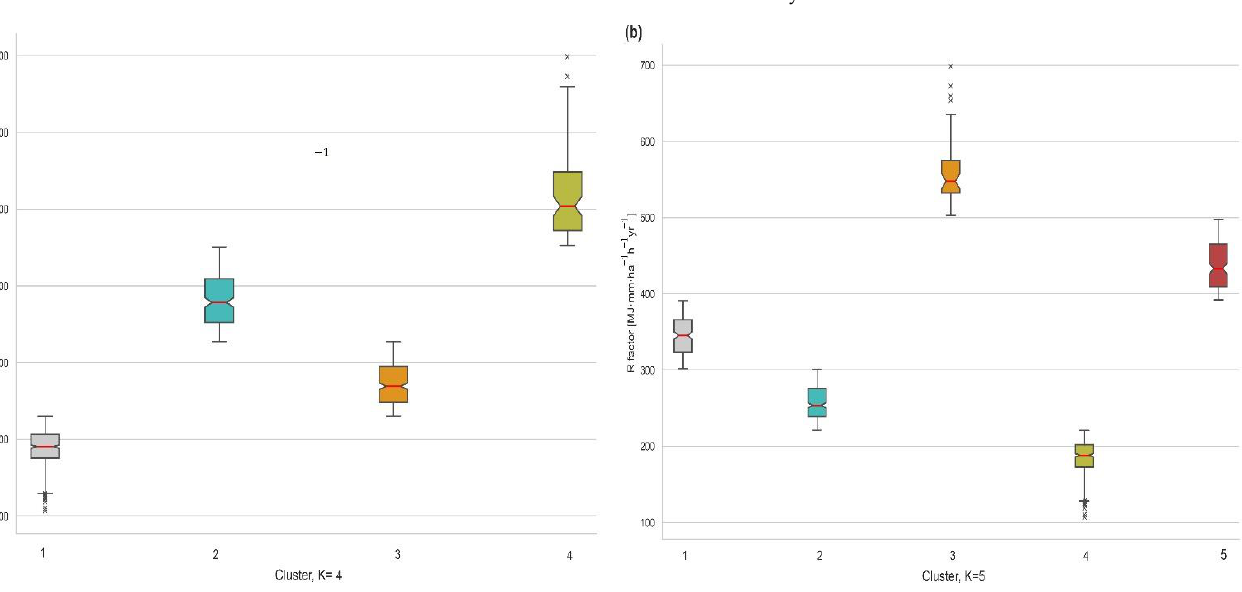
Figure 9. The difference in the R-factor distribution (RUSLE methodology) between the clusters for the total 30-year period if ( a ) K = 4 and ( b ) K = 5.